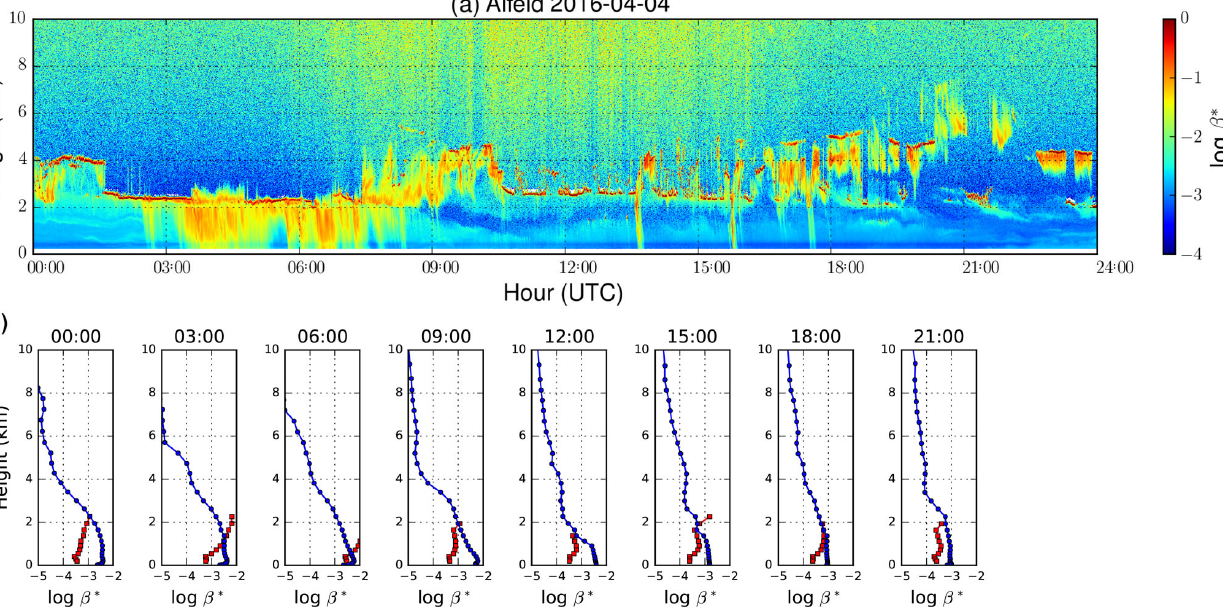
Figure A3. Time series of attenuated backscatter measured by the ceilometer (a) and simulated by the model (b) in Alfeld during a dust episode on 4 April